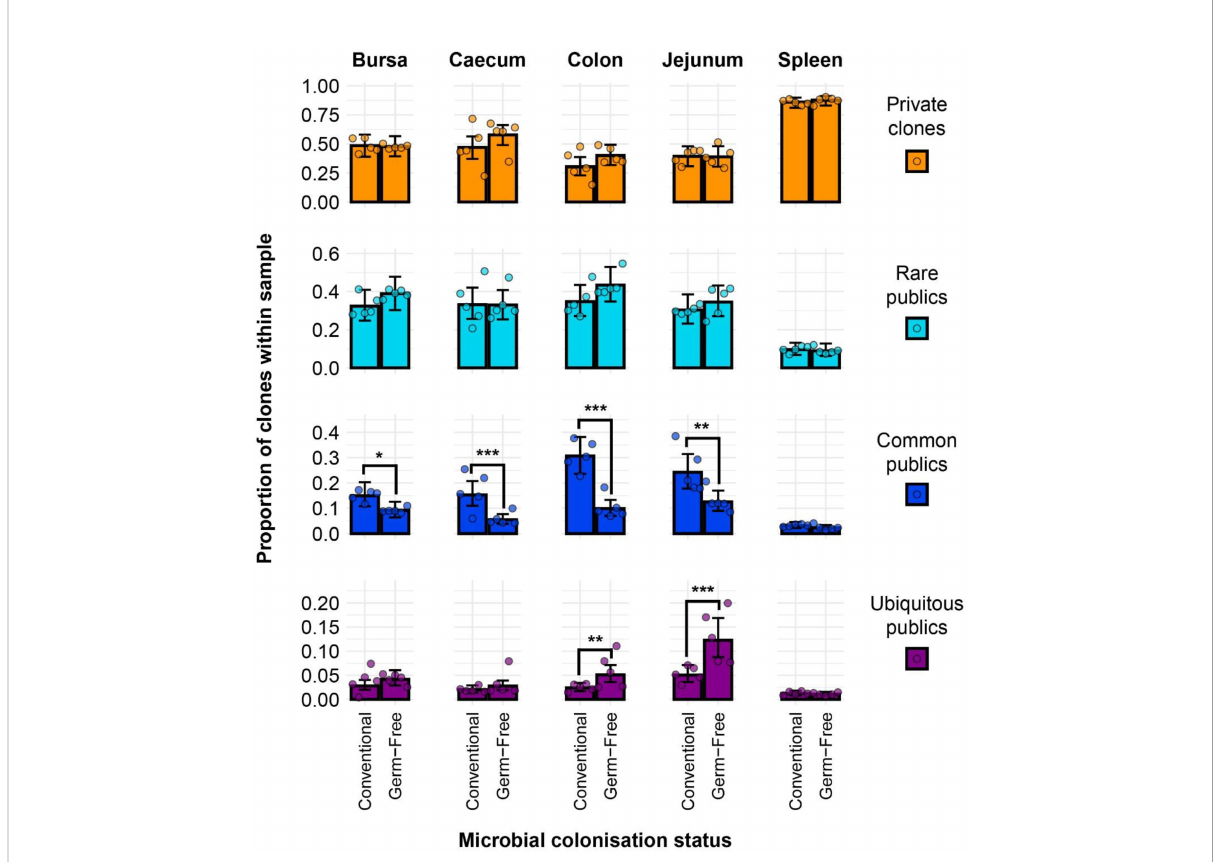
FIGURE 5 TCR b clone CDR3 nucleotide private and public compartments based on different levels of clonal sharing between birds. Private (individual- restricted) clones are shown in orange. Rare publics (shared between ≥ 2 individuals and up to 5) and are shown in light blue. Common publics (shared between ≥ 5 and up to 9 birds) are shown in dark blue. Ubiquitous publics (found in all birds which were incorporated in the analysis) are shown in purple. Dots represent individual bird observations of private and distinct public clonal compartments. Error bars represent 95% bootstrap con fi dence intervals for the point estimates generated from 1000 simulations of the model. Statistically signi fi cant differences between the model estimates are depicted above the plots based on their corresponding p-values: *p < 0.05; **p < 0.01, ***p <